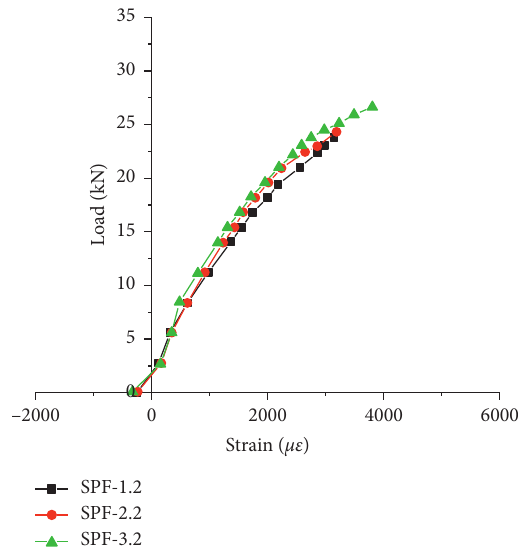
Figure 11: Load-strain curve of the fifth-layer laminate of the test beam in group B.